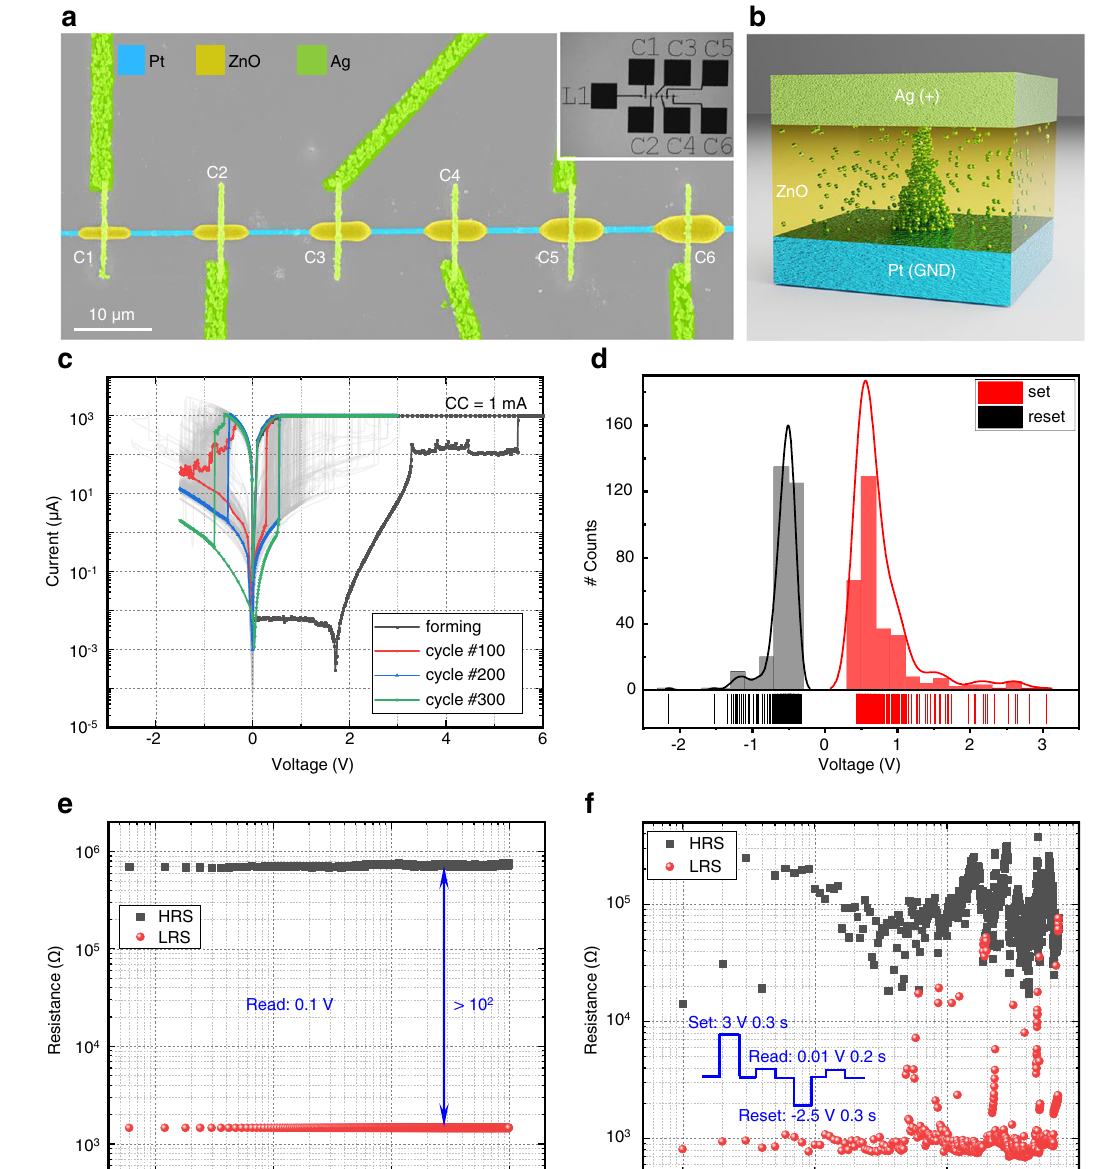
Fig. 4 | Laser-printed crossbar Pt – ZnO – Ag memristor device. a 1×6 crossbar structure with varying ZnO linewidths, realized by controlling the laser power during laser printing. The electrical performance of the crossbar structure is determined by the dimensions of the ZnO layer. b Scheme of the mechanism at work. c Current – voltage characteristics of a single memristor for 300 cycles. The forming process (black), cycle number 100 (red), cycle number 200 (blue), and